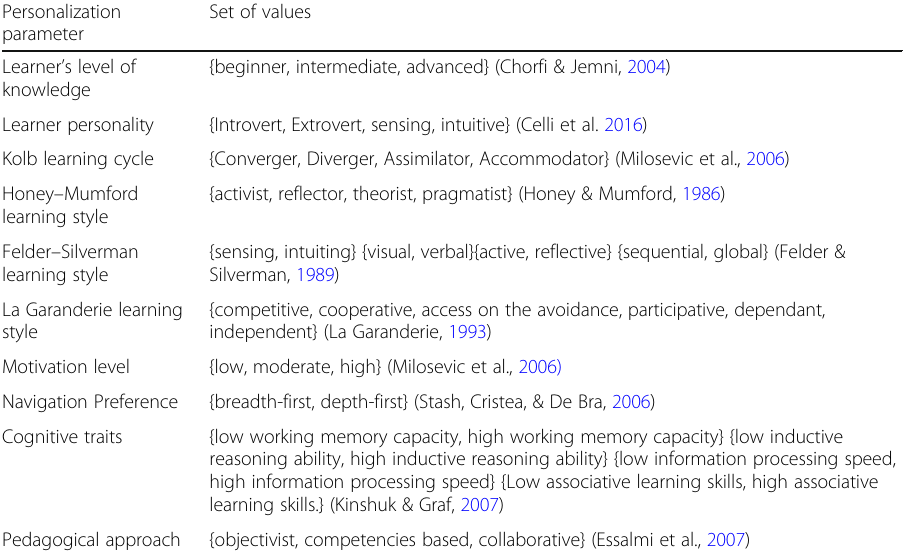
Table 2 Examples of values for the personalization parameters (Essalmi et al., 2010) Personalization parameter